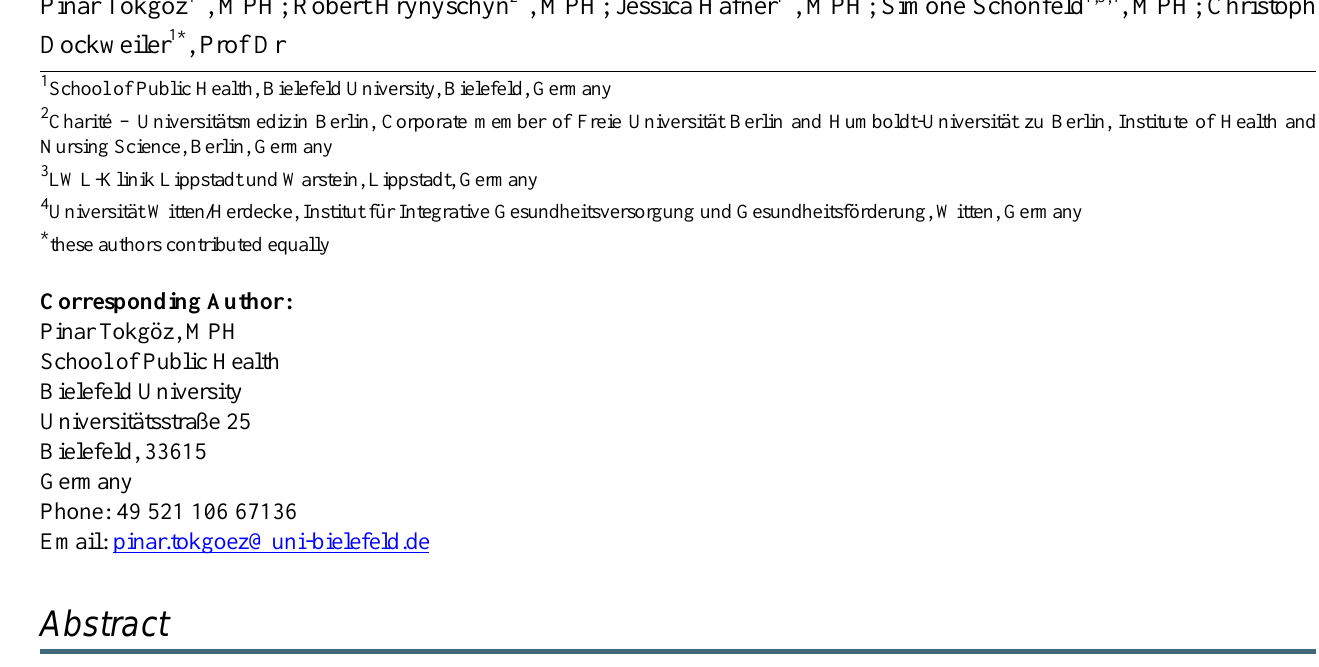
digital health; depression; scoping review; health